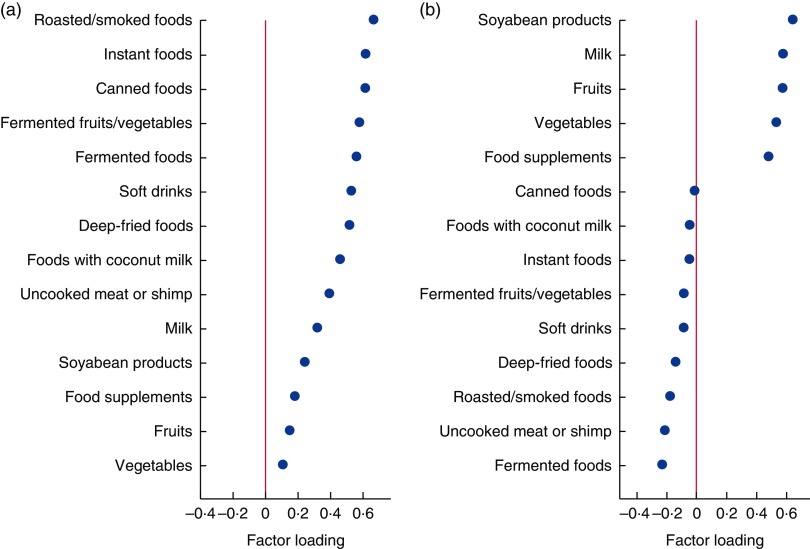
(colour online) Factor loadings of baseline dietary patterns identified in Thai Cohort Study participants (n 81725): (a) Modern dietary pattern; (b) Prudent dietary pattern